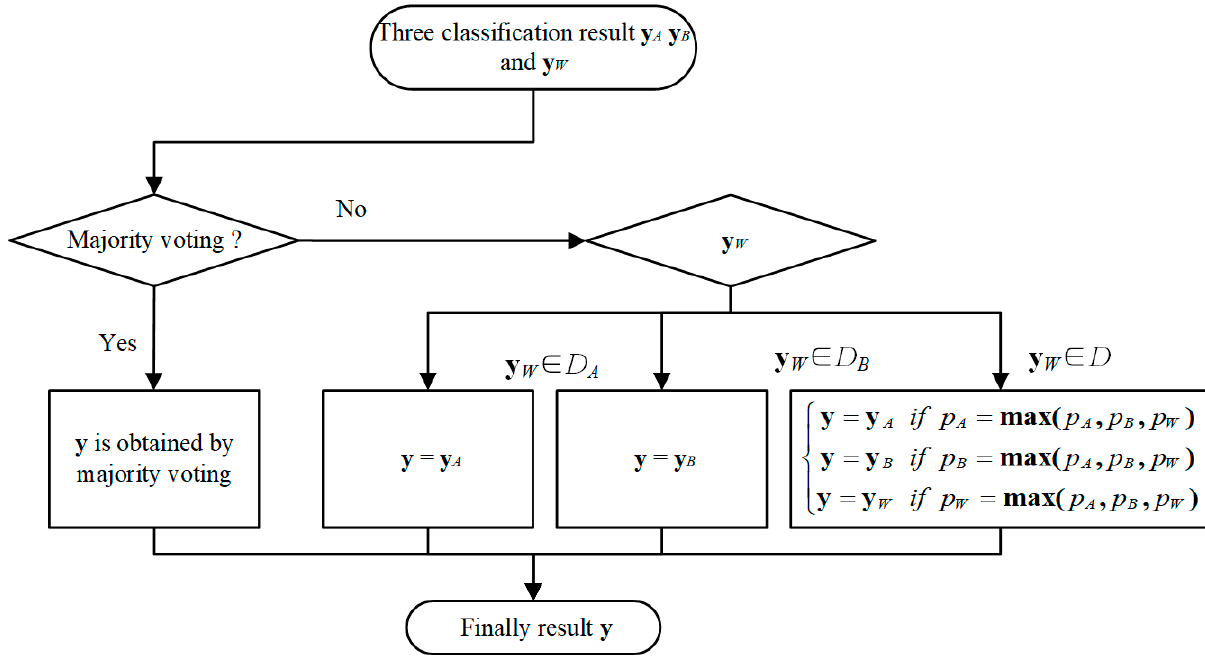
Figure 5. The flowchart of the classifiers’ ensemble.